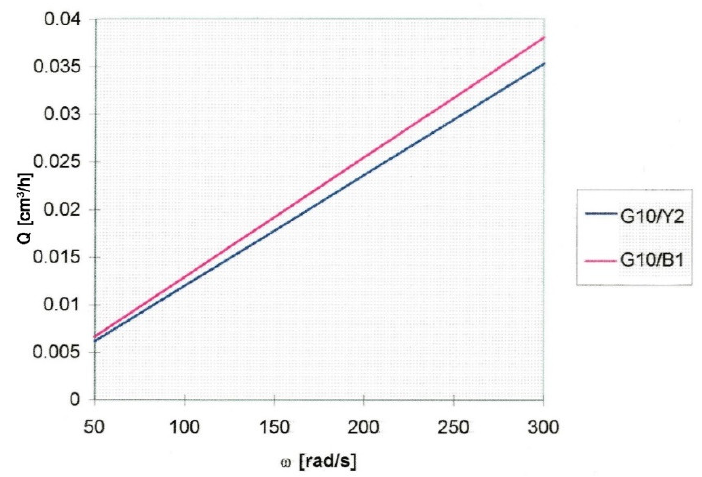
Figure 16. Variation of the leakage loss flow at a frontal seal EF19 × 45.4 × 13.3 depending on the angular speed and for different material couplings of the primary seal.